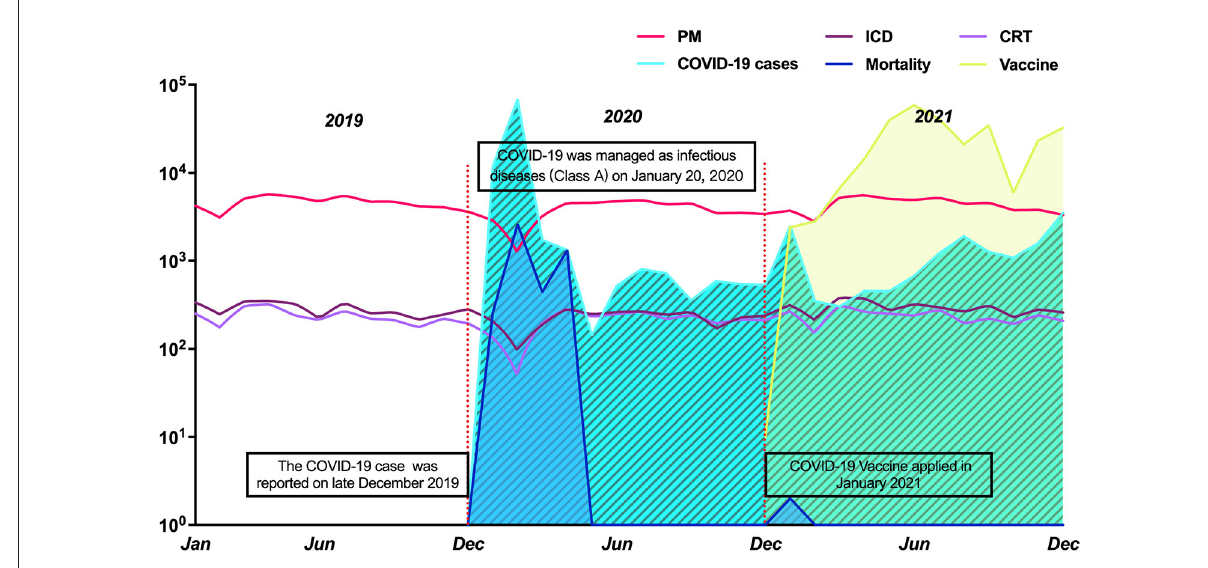
FIGURE1 The trend of CIED implantation from 2019 to 2021 and COVID-19 pandemic in China. COVID-19: Coronavirus disease 2019; CRT, cardiac resynchronization therapy; ICD, implantable cardiac defibrillator; PM, pacemaker.